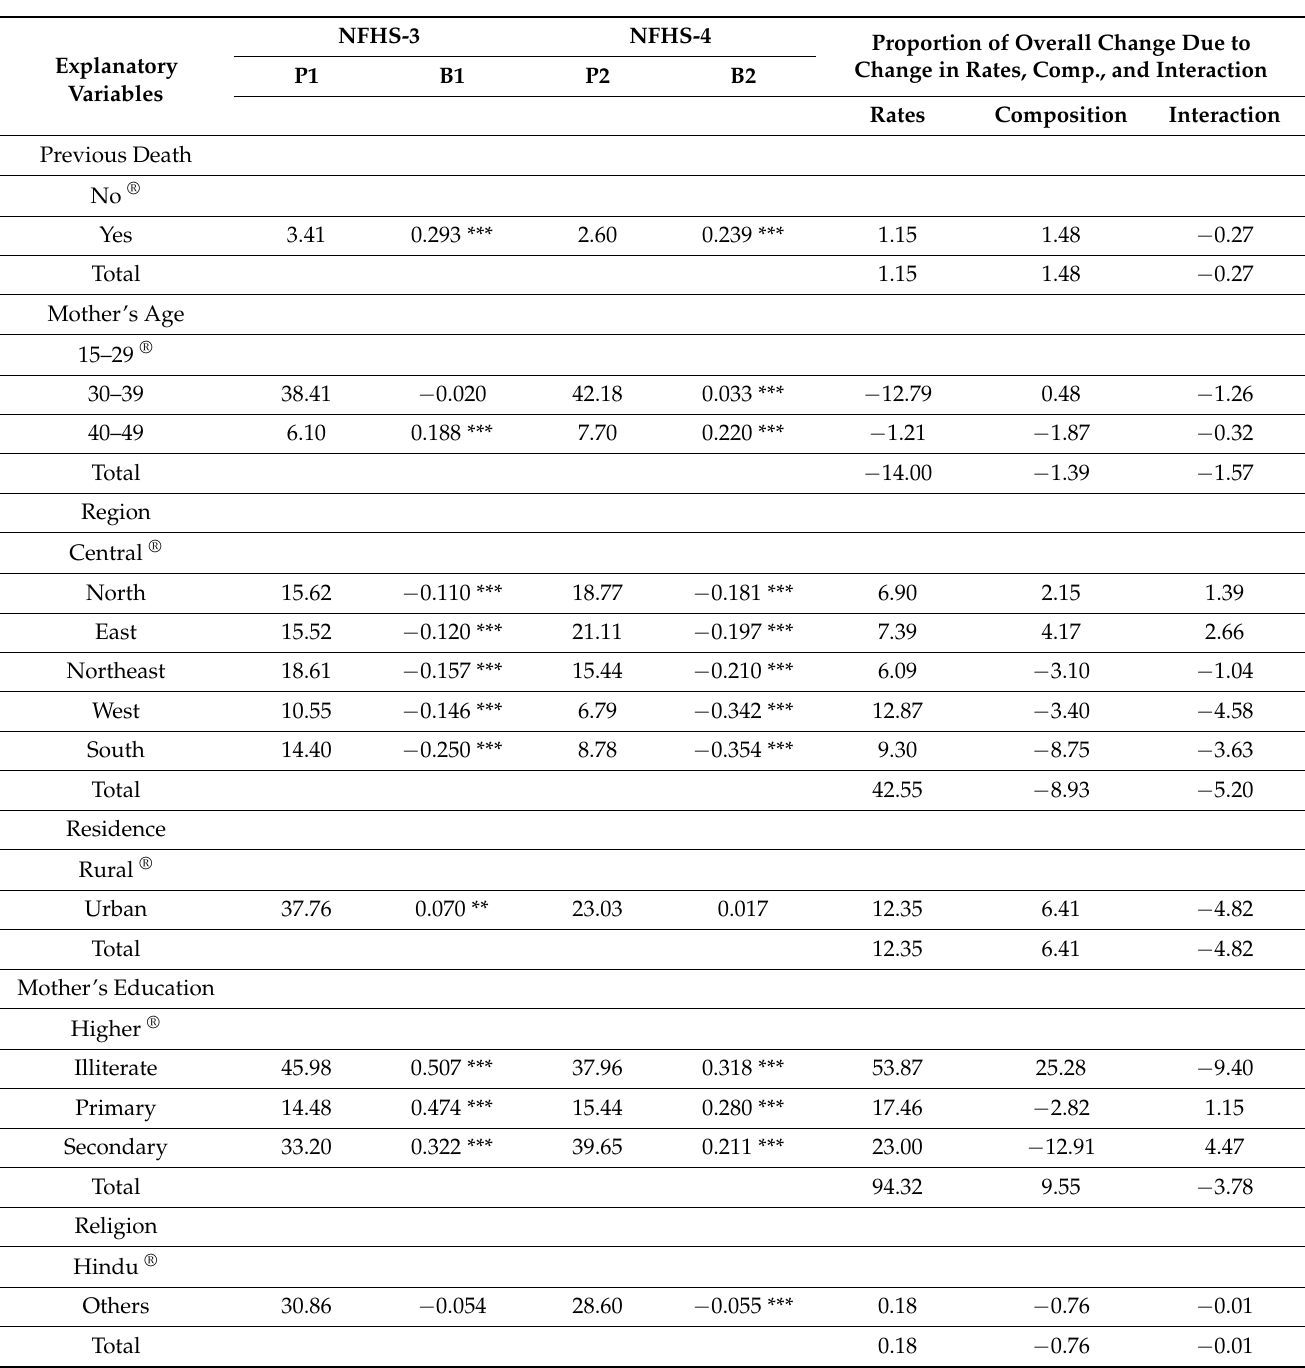
Table 7. Result of random effects dynamic probit model decomposition analysis of infant mortality into factors, India, 2006 and